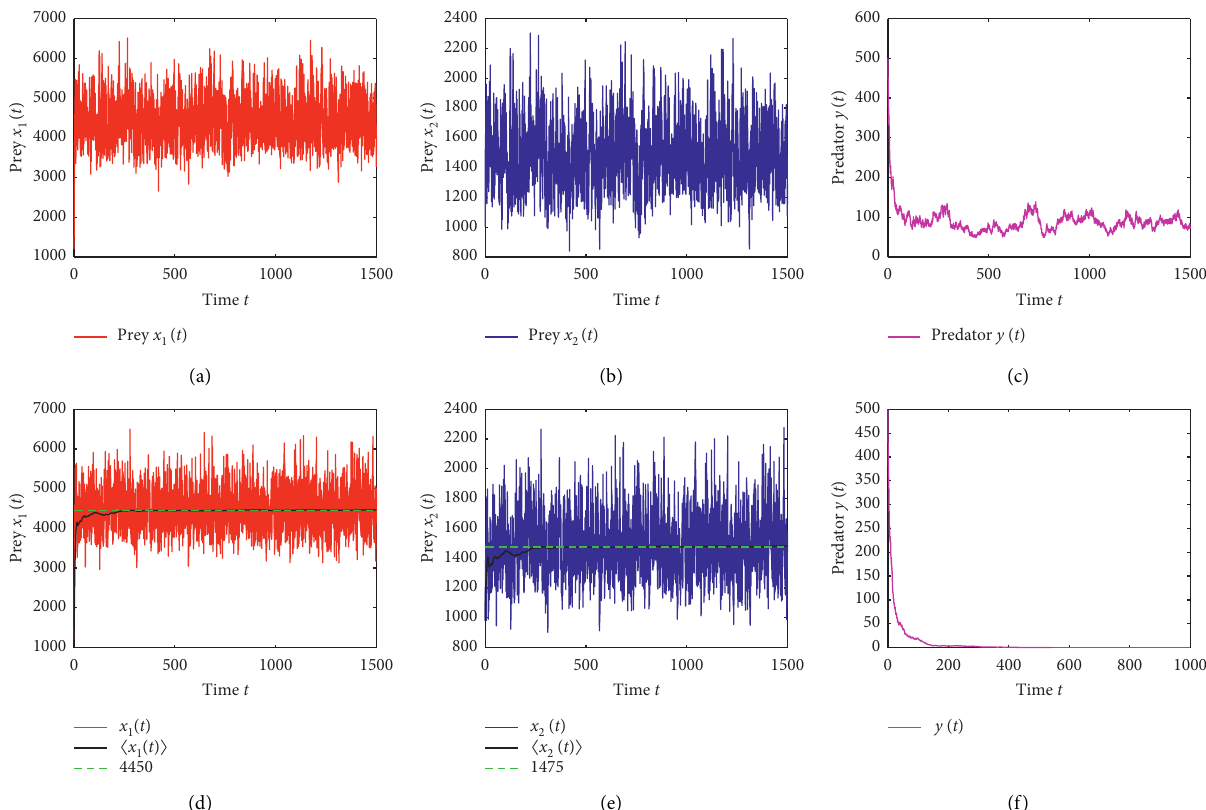
Figure 23: The trajectories of stochastic model (5) with different v (color figure online): (a) prey x v � 0 . 8, (c) predator y ( t ) with v � 0 . 8, (d) prey x